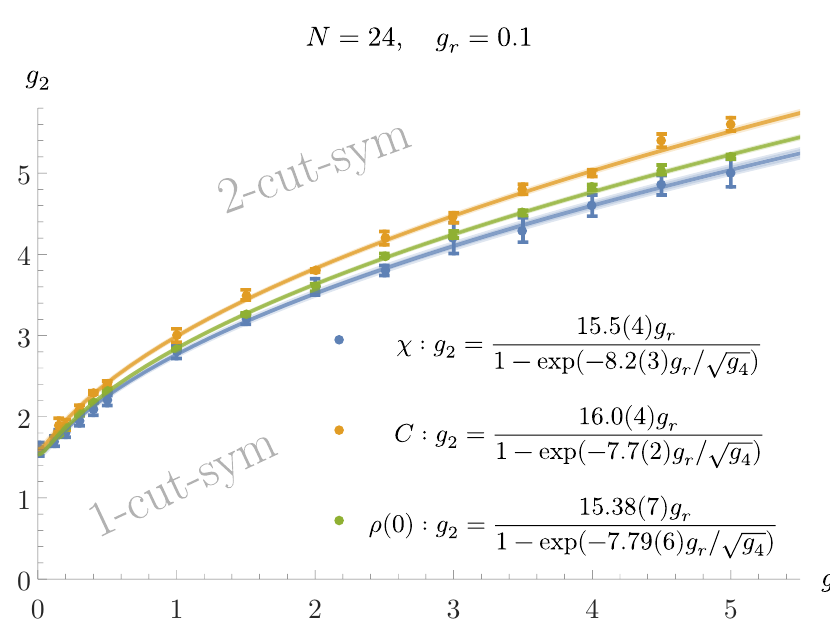
Figure 4 . Hybrid Monte Carlo phase diagram constructed from peaks in C and χ , and from split- ting points of eigenvalue distribution ρ (0) = 0 . A simple function g is a good approximation for the numerical transition lines and correctly reproduces theoretical ex- pression up to O ( g 3 ) r